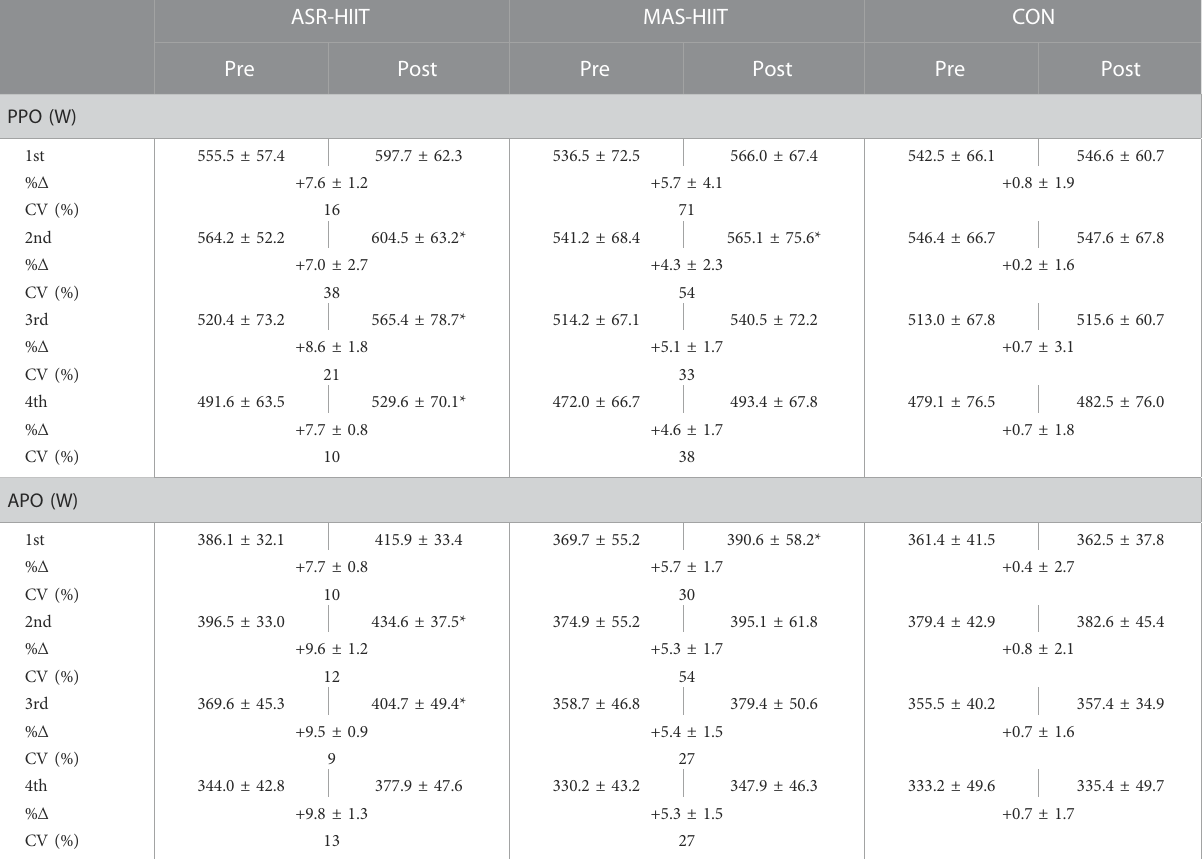
TABLE 3 Pre-training vs. post-training values for upper-body peak and average power output during four consecutive wingate trials. ASR-HIIT MAS-HIIT CON